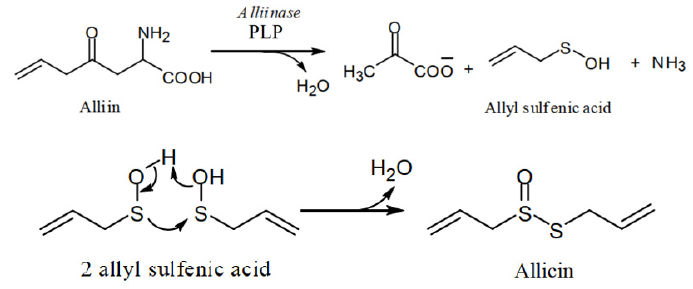
Figure 3. An elaborated scheme of allicin biosynthesis from alliin.